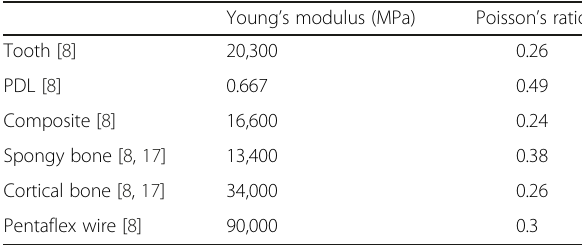
Table 1 Mechanical properties of the materials used in